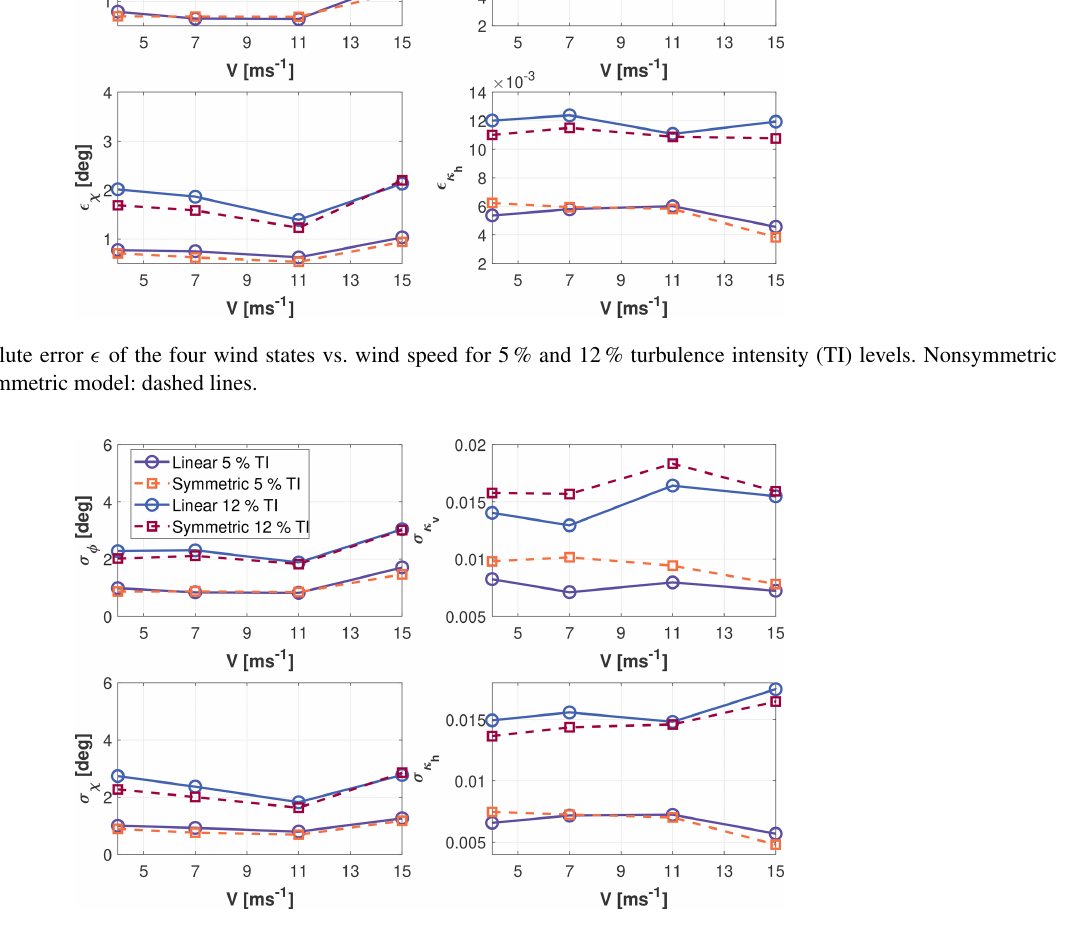
Figure 3. Standard deviation σ of the four wind states vs. wind speed for 5% and 12% turbulence intensity (TI) levels. Nonsymmetric model: solid lines; symmetric model: dashed